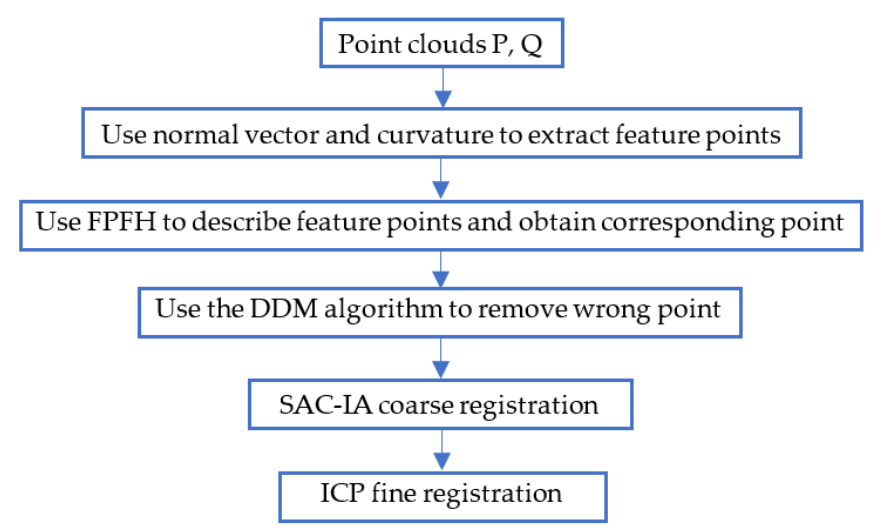
Figure 1. Flowchart of the proposed algorithm.